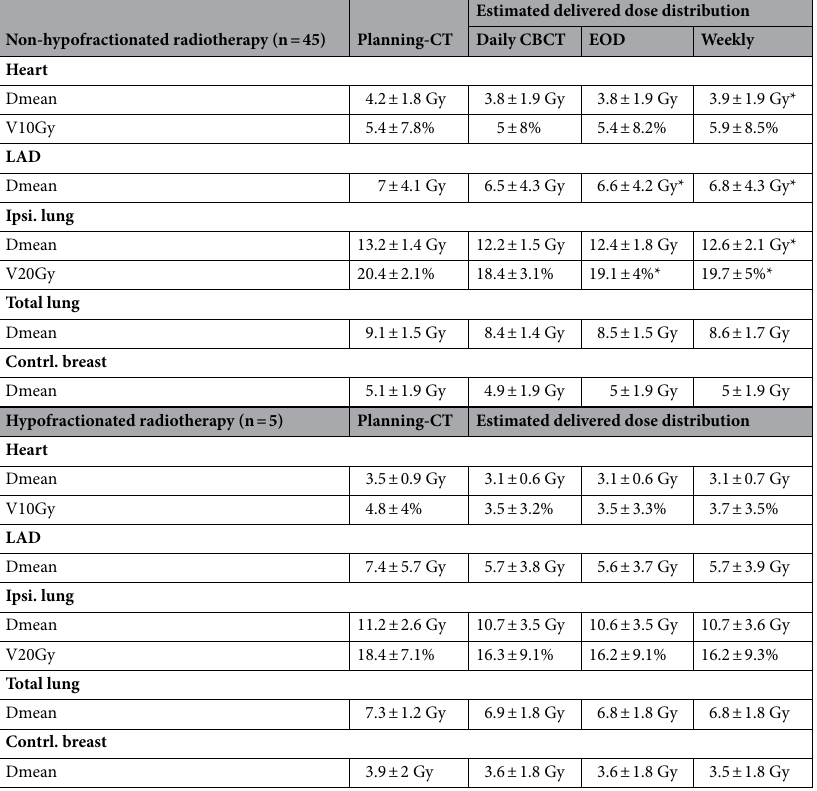
Table 3. Dose coverage in the OARs in the planning CT compared and the estimated delivered dose distribution in dependence of CBCT-frequency. Mean values and standard deviation. *Significantly different from daily CBCT ( p < 0.05).